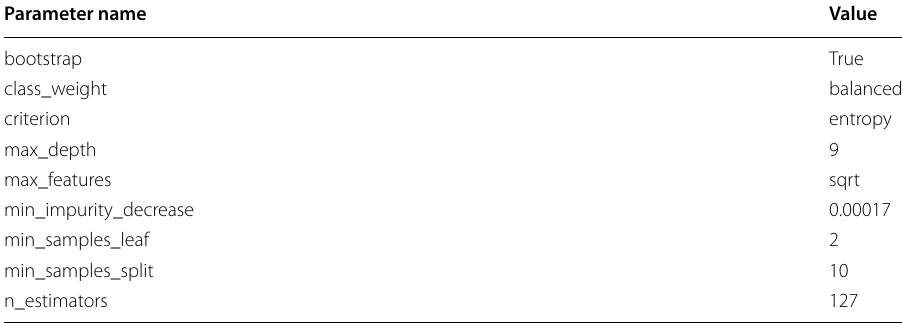
Table 84 Modes of RF tuned hyperparameter values for experiments with the data exfiltration